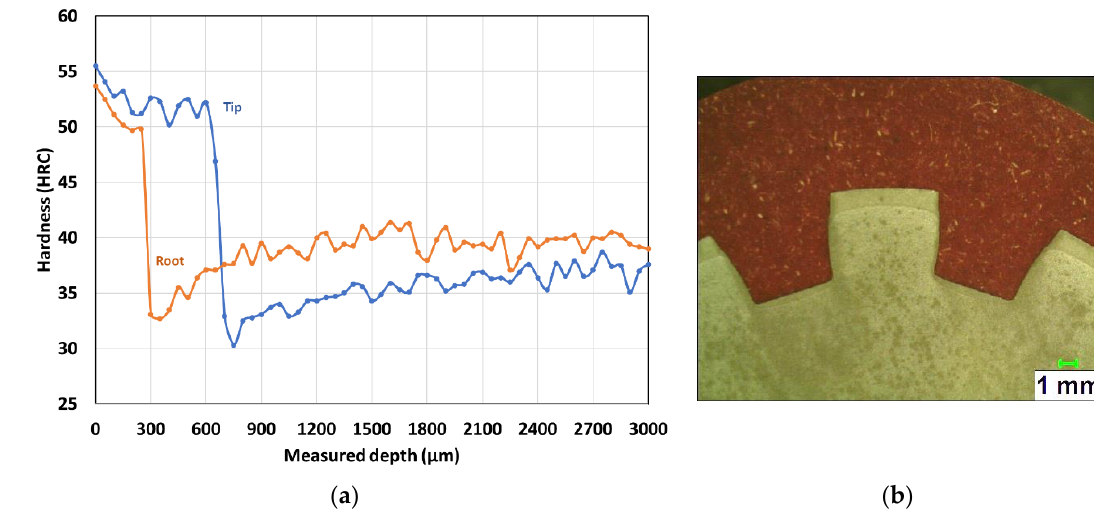
Figure 3. Hardness results for laser heat treatment for test 5: ( a ) micro-hardness measurement [HRC] in different depths [µm] at tip and root of spline ’s tooth and ( b ) visualized hardness profile of a cross-section of the spline shaft.